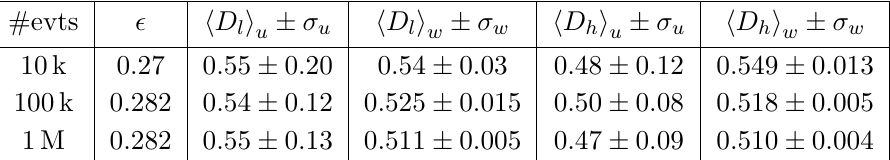
Table 6. Comparison of the classi(cid:12)ers D f , with f = l; h calculated as weighted and unweighted